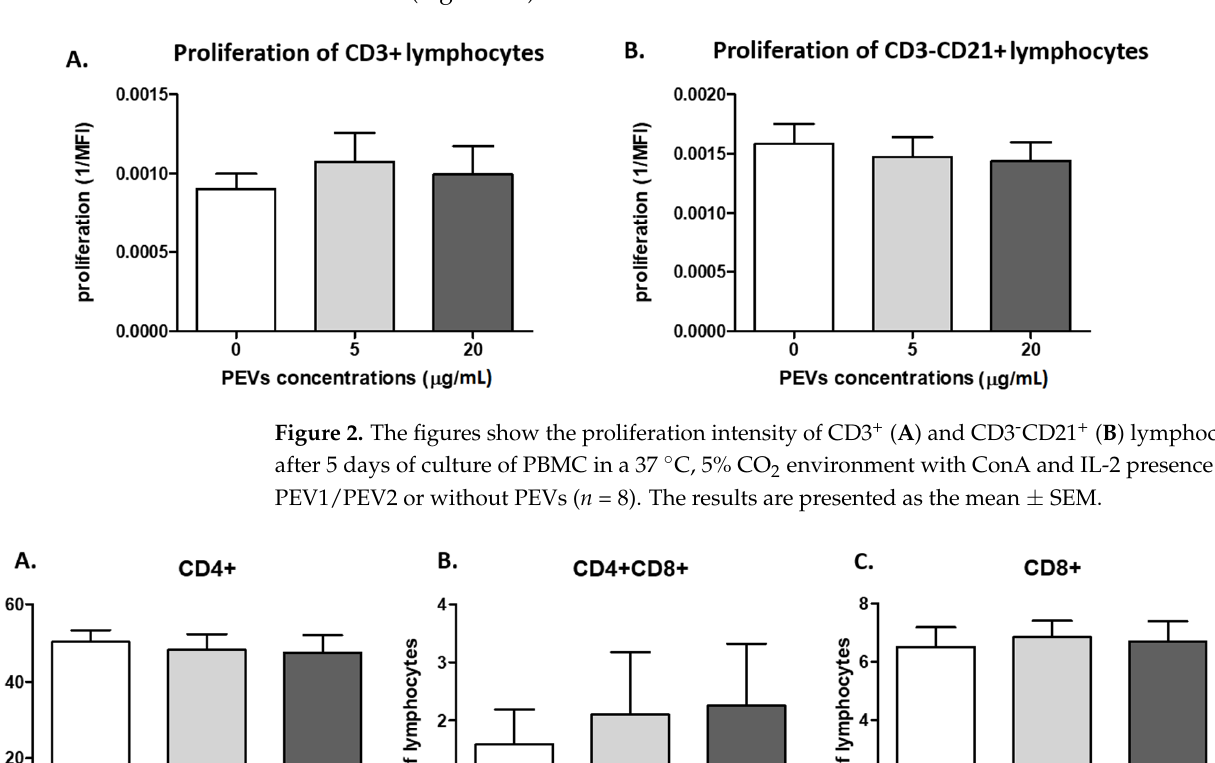
There was no PEV influence on T lymphocytes immunophenotype ( p > 0.05). The CD4 + cell percentage was 50.3 ± 8.5% in the control, 48.2 ± 11.6% with PEV1 and 47.5 ± 12.7% for PEV2, respectively (Figure 3A). The percentage of double-positive cells (CD4 + CD8 + ) was 1.5 ± 1.7%, 2.1 ± 3.1% and 2.25 ± 3.0% (Figure 3B) and for CD8 + lympho- cytes, 6.5 ± 1.9%, 6.8 ± 1.5% and 6.6 ± 2.0%, respectively (Figure 3C).